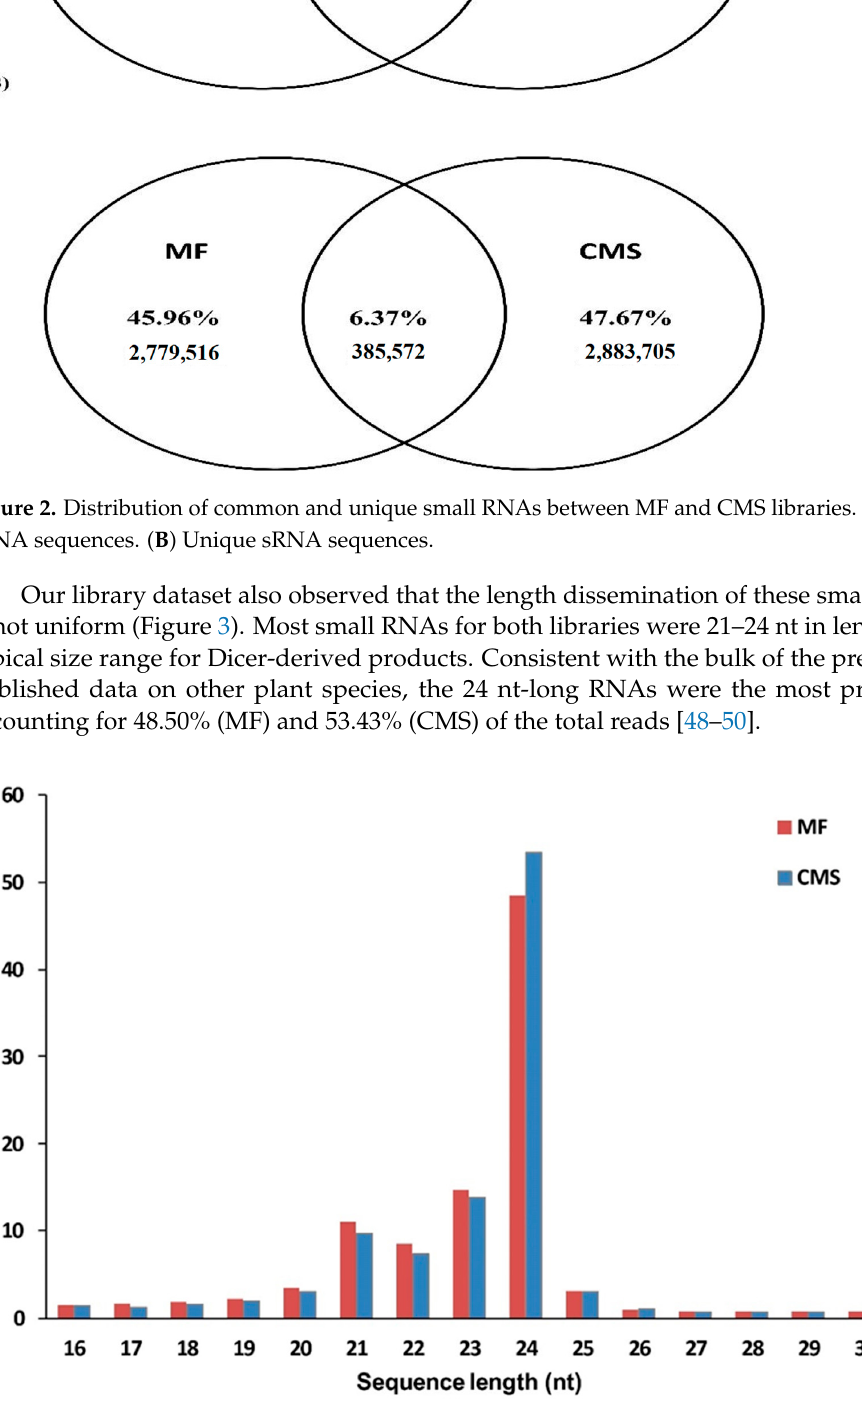
Figure 3. The size distribution of the small RNAs between MF and CMS libraries of cabbage.